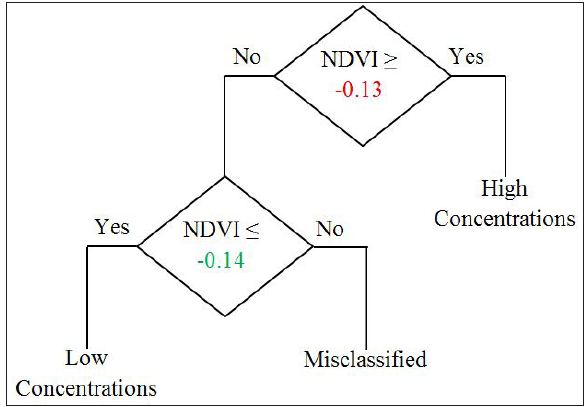
Figure 3: Normalised difference vegetation index (NDVI) classification scheme used in the study to separate chl- a concentrations into two classes. Descriptive statistics of two chl- a classes from the normalised difference vegetation index (NDVI) calculated using red and near-infrared bands of Landsat OLI data, and the NDVI